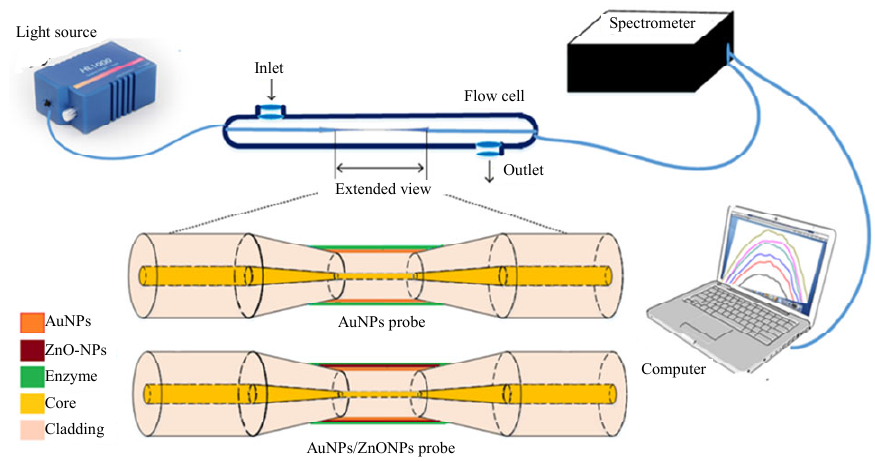
Fig. 4 Experimental setup for the sensing of ascorbic acid through the tapered fiber sensor